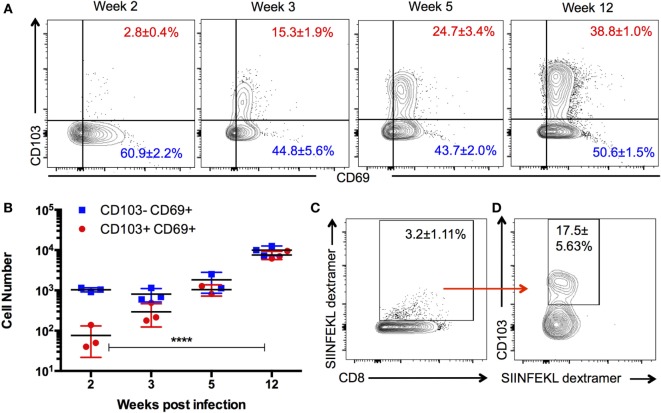
Kinetics and specificity of CD103+ CD8 T cells in the Toxoplasma-infected brain. Brain mononuclear cells harvested from Toxoplasma gondii-infected mice at indicated time points and gated on live CD3+ CD8+ cells. (A) Numbers indicate the proportion of CD69+ CD103+ and CD69+ CD103− CD8 T cells in the brain at the indicated time points. (B) Absolute cell counts for the data are shown in panel (A). (C) Percentage of dextramer+ CD8 T cells in the brain. (D) Percentage of SIINFEKL dextramer+ CD8 T cells expressing CD103. Data from week 12 postinfection. Numbers indicate average ± SEM of three biological replicates for each time point. Significance was determined using two-way ANOVA with multiple comparisons post test. ****p < 0.0001. Data are representative of two independent experiments with similar results.